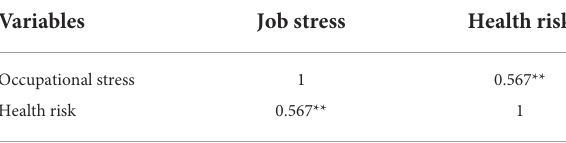
TABLE 16 Correlation and regression analysis to explore the influence of Occupational stress on health risk. Variables Job stress Health